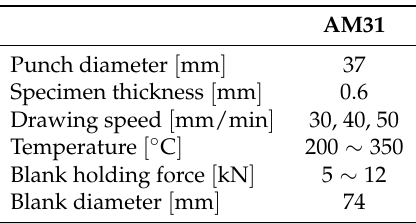
Table 1. Deep drawing